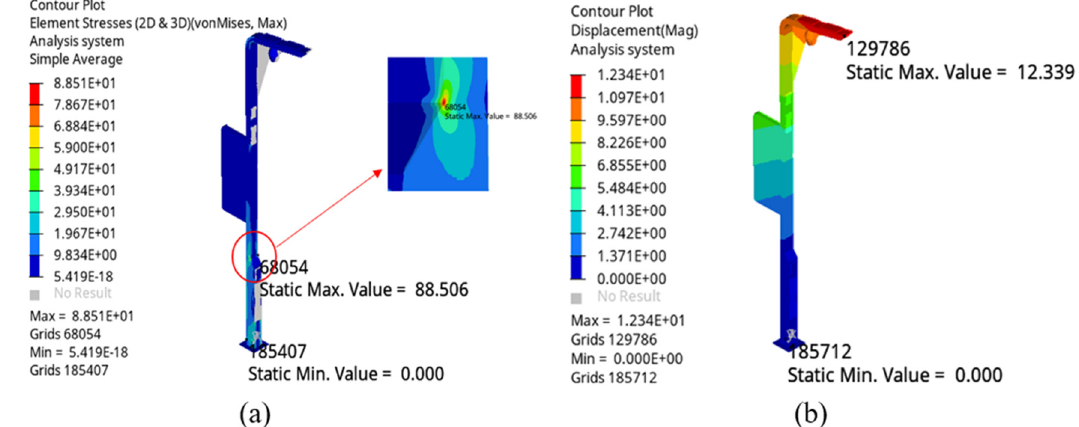
Figure 5: The cloud diagram under full load condition of typhoon: ( a ) stress and ( b ) displacement.